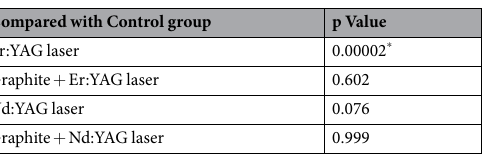
Compared with Control group